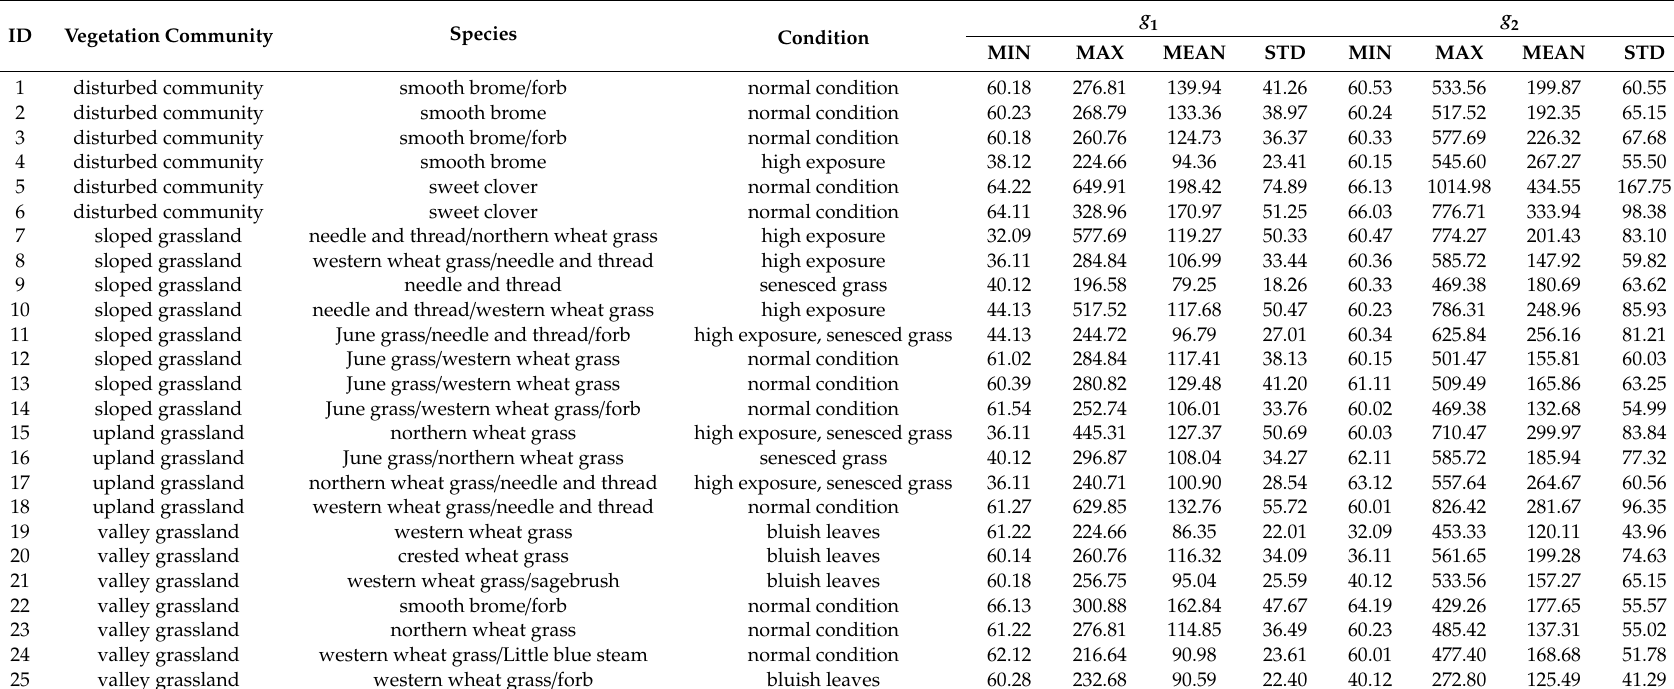
Table 3. Data exploration for constant g 1 , g 2 for di ff erent species and